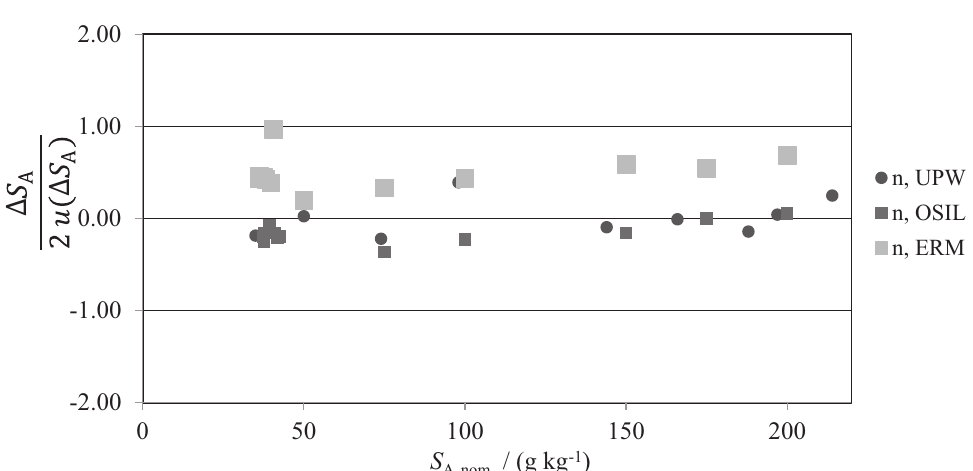
Fig. 6. Ratios D S A 2 u D S between pairs of salinity values from refractometry and densimetry ( S A ( n ); S A ( r )), as a function of the A ð Þ absolute salinity, S A nom , for NaCl in ultrapure water (UPW), OSIL SSW and ERM